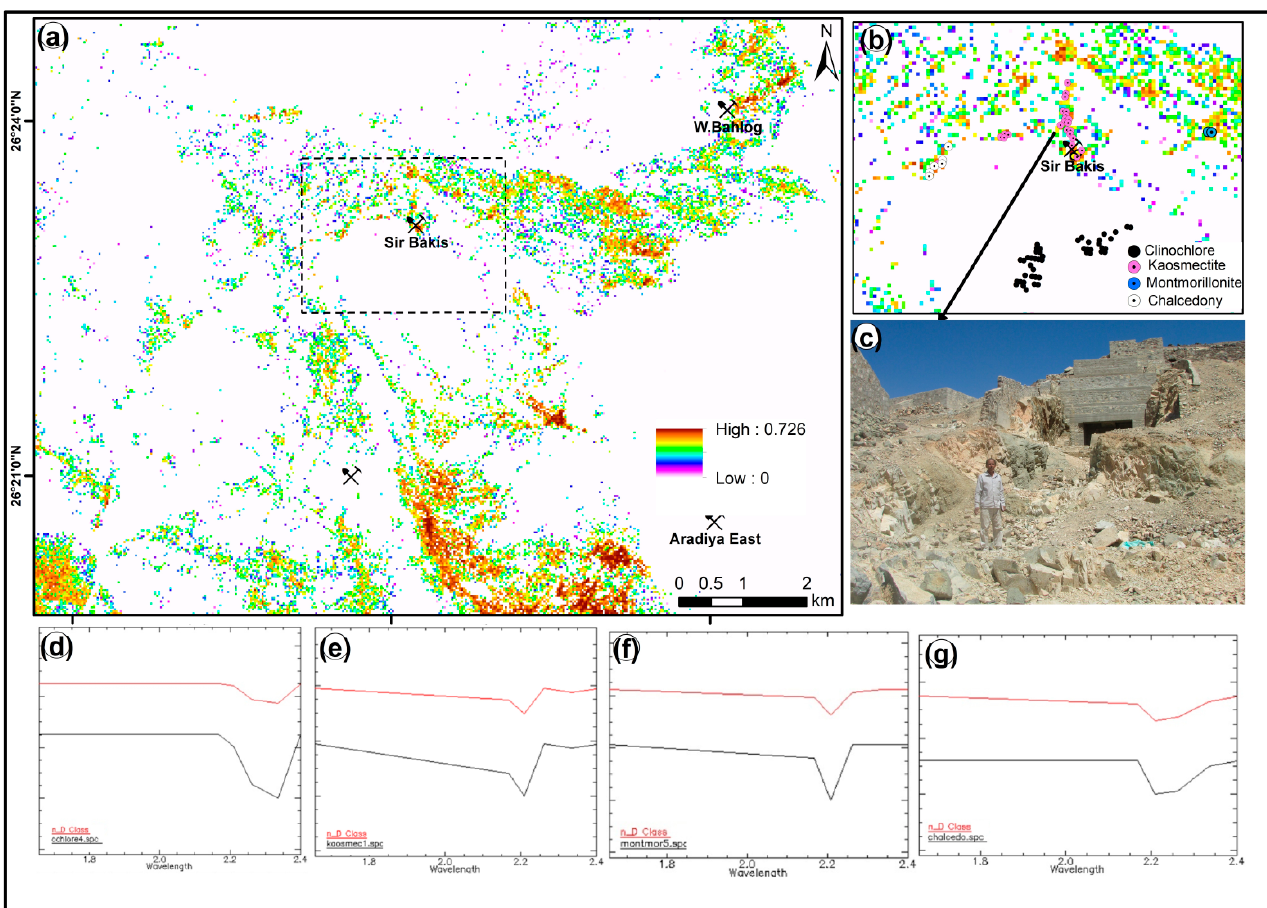
Figure 7. ( a ) Combined alteration zones from Landsat OLI, Sentinel-2, and ASTER data color coded based on intensity of hydrothermal alteration; ( b ) enlargement of mine areas overlain by extracted spectra showing the distribution of chlorite, kaolinite/ smectite, montmorillonite, and chalcedony as circles in black, green, blue, and white, respectively; ( c ) field image for the Sir Bakis gold mine; ( d – g ) extracted absorption spectra for chlorite ( d ), kaolinite/ smectite ( e ), montmorillonite ( f ), and chalcedony ( g ), all based on spectral signature of ASTER SWIR data. The red curves represent the extracted spectra; black curves are the USGS reference spectra.